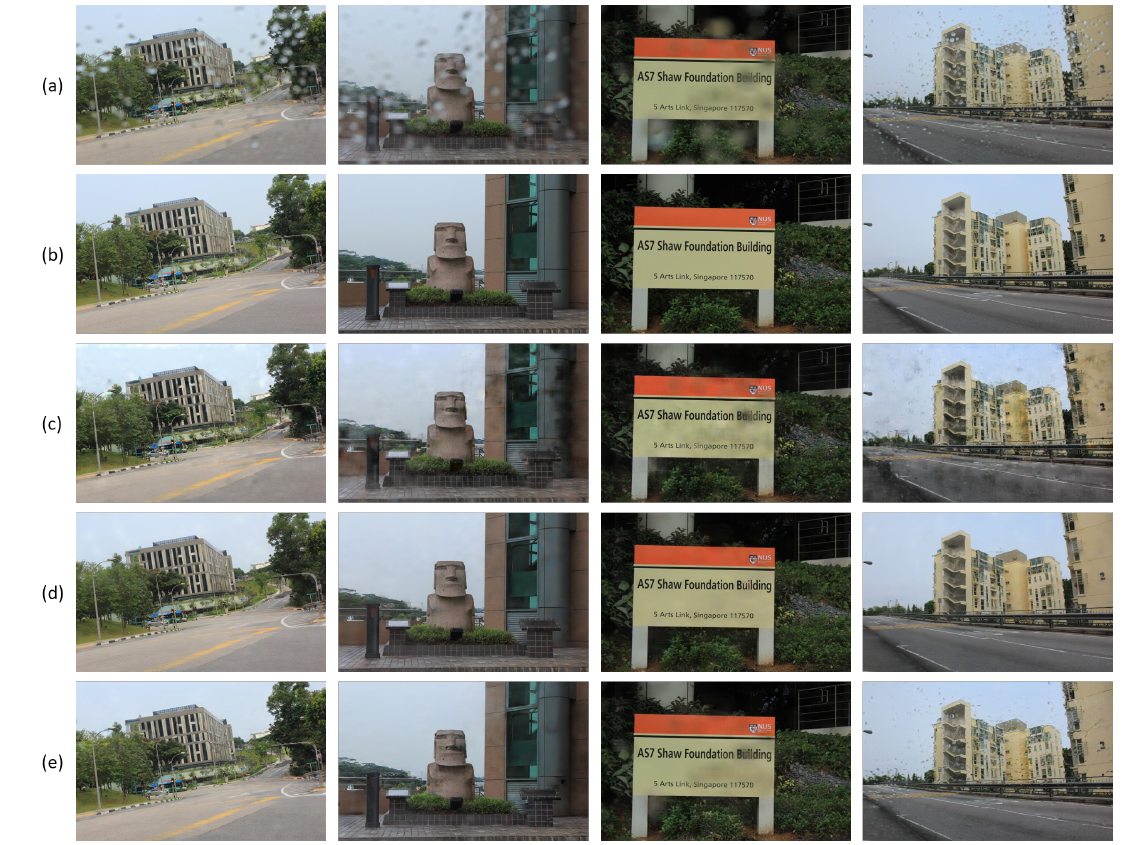
Figure 7. Test examples from the Raindrop1119 dataset: ( a ) distorted examples; ( b ) their corresponding clean images (ground-truth); and the reconstruction results of ( c ) Pix2Pix ; ( d ) attentive GAN ; and ( e ) the proposed Raindrop-aware GAN